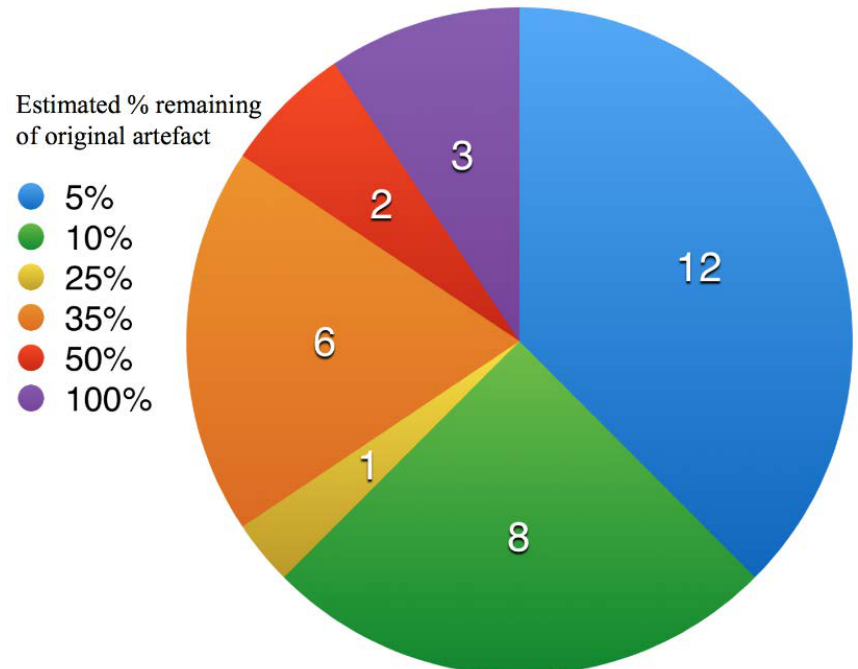
Figure 5. Condition of the basalt